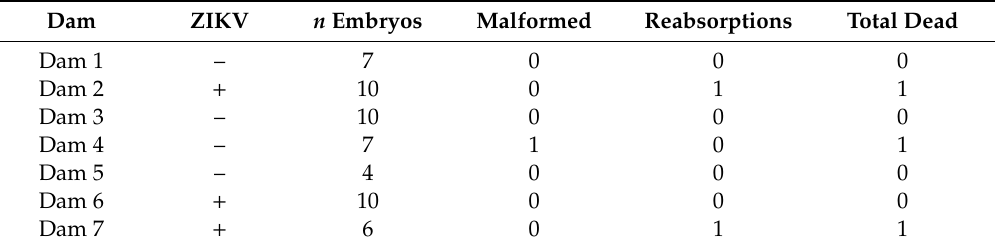
Figure 1. The ZIKV effect on FVB/NJ mice dams and fetuses. The FVB/NJ mice were infected intravaginally with 10 µl of ZIKV (1.0 × 10 5 PFU) or PBS (MOCK infection) on the gestational day (GD) 4.5. The dam weight was determined on the GDs 4.5, 11.5 and 17.5. ( B ) Representative images of embryos derived from either the MOCK- or ZIKV-infected dams are shown. The graphs show the weight of the ( A ) dams, ( C ) fetuses and ( D ) placentae. The data represent the means ± SEM. * indicates a significant difference, as compared to MOCK ( p < 0.05). Table 2. ZIKV- and MOCK-infected dams and